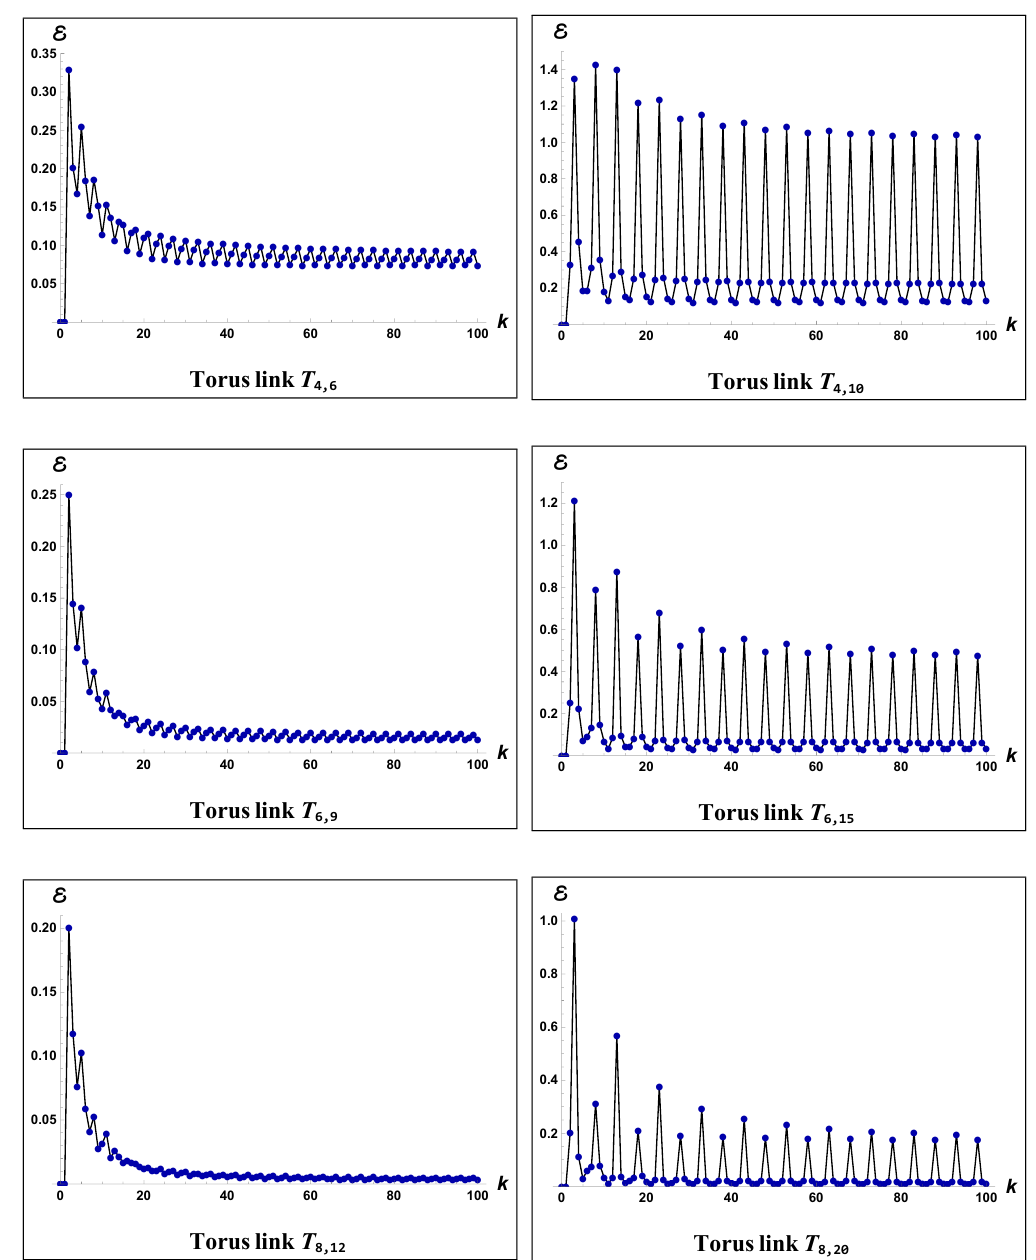
Figure 11. The variation of the SU (2) k entanglement entropy with k for some of the torus links T p,q which are not of the form of T p,pn . The black line is some interpolation